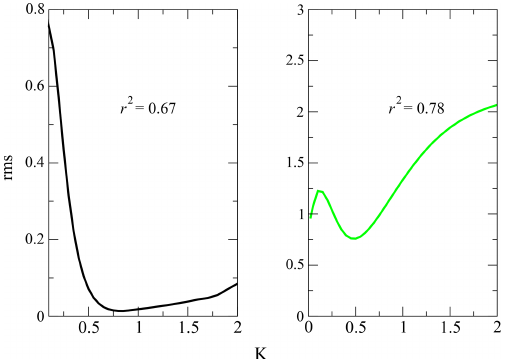
Figure 5. Plots of the curves of the root mean square (rms) differ- ences between the optical depths retrieved from FIRMOS and the lidar as a function of the power-law exponent k for the ice (black) and mixed (green) clouds. r 2 denotes the correlation index.